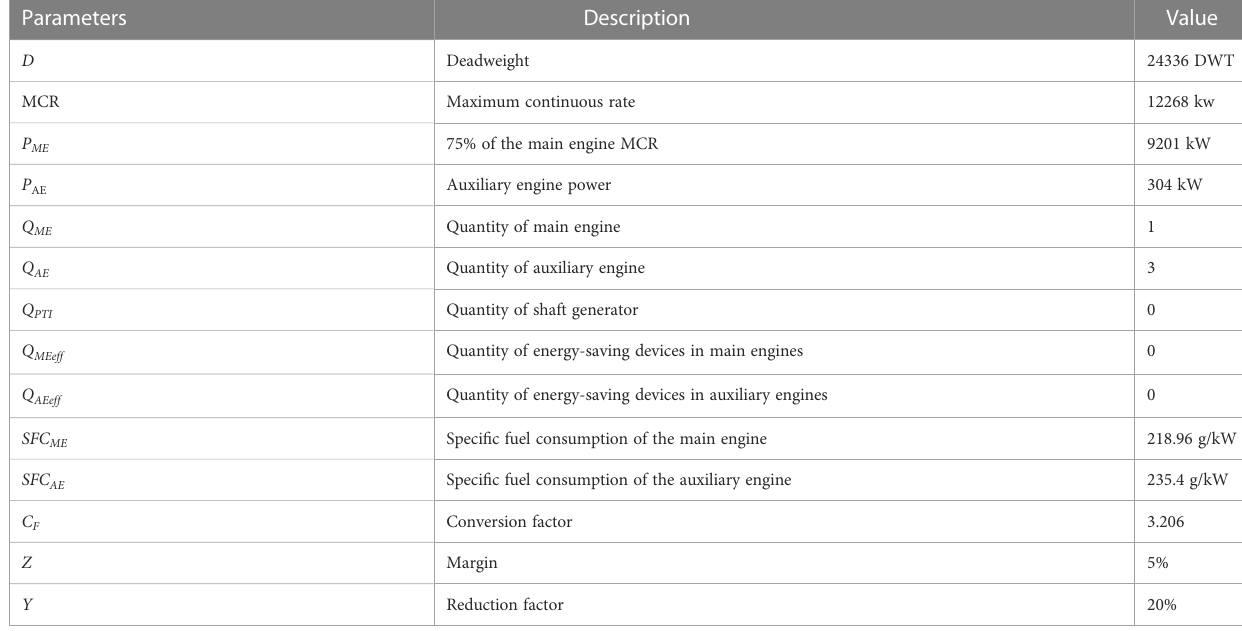
TABLE 4 Parameters for calculating